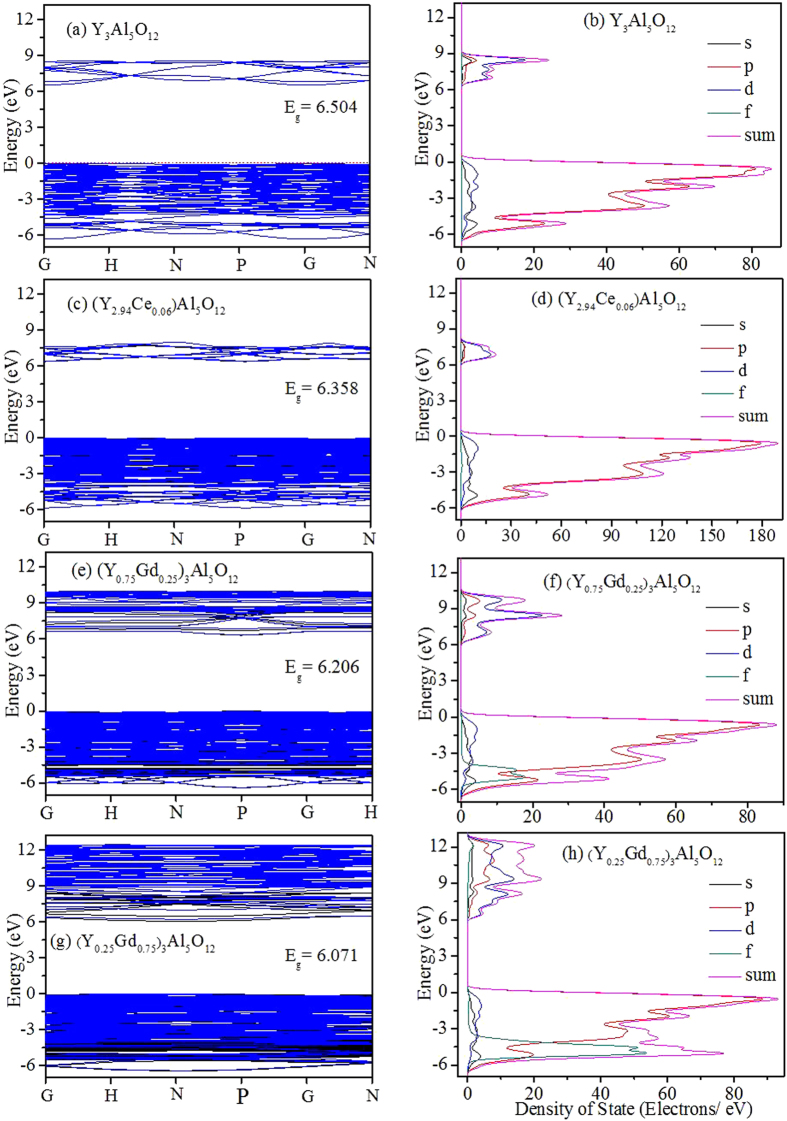
Band structures, density of state, and partial density of state of Y3Al5O12, (Y2.94Ce0.06)Al5O12, (Y0.75Gd0.25)3Al5O12, and (Y0.25Gd0.75)3Al5O12.